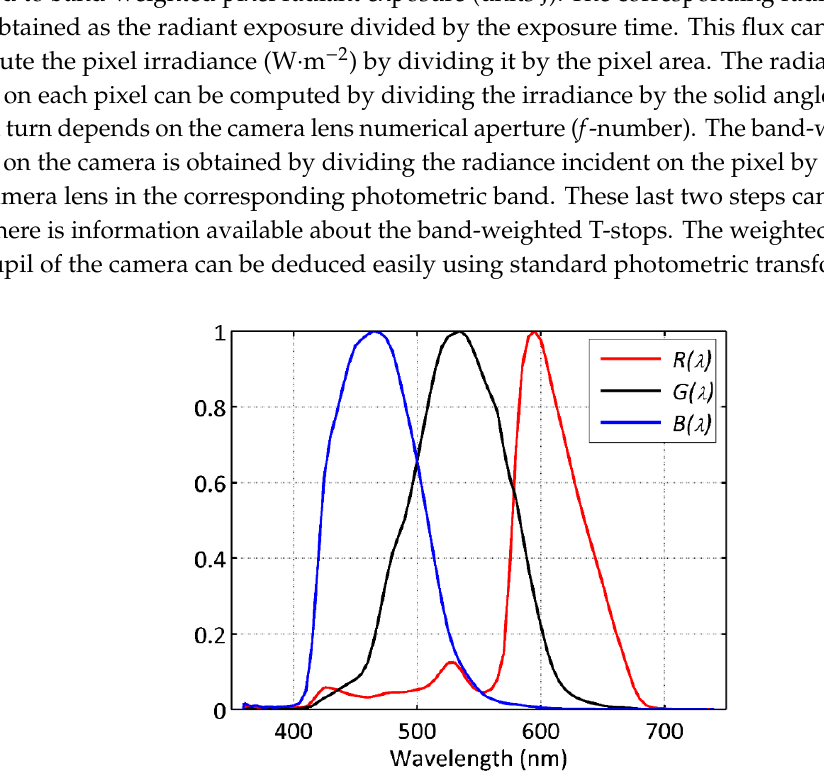
Figure 2. 𝑅(cid:4666)𝜆(cid:4667) , 𝐺(cid:4666)𝜆(cid:4667) , and 𝐵(cid:4666)𝜆(cid:4667) functions of a Nikon D3s camera, measured at LICA facility (Laboratorio de Instrumentación Científica Avanzada of Universidad Complutense de